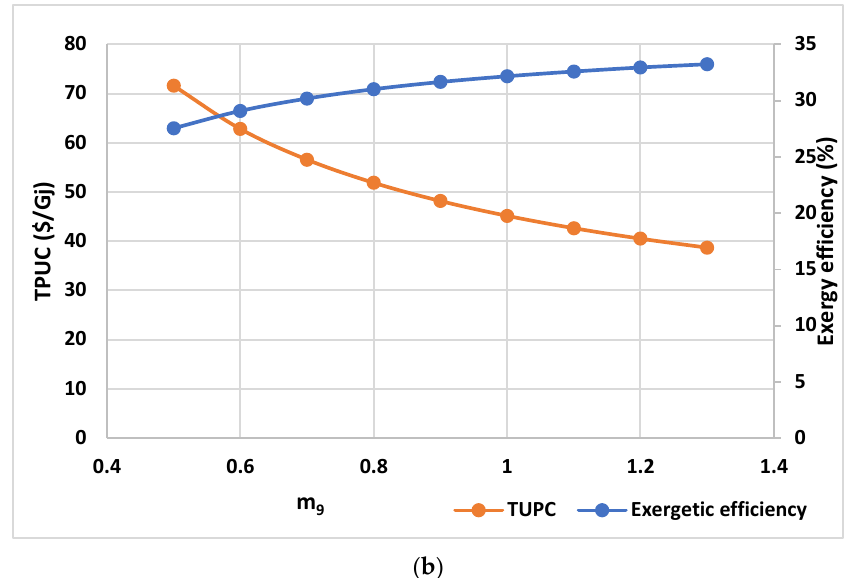
Figure 12. ( a ) Effect of secondary mass flow rate of the first ejector on energy efficiency, cooling, and power generation. ( b ) Effect of the secondary mass flow rate of the first ejector on exergy efficiency and TPUC.